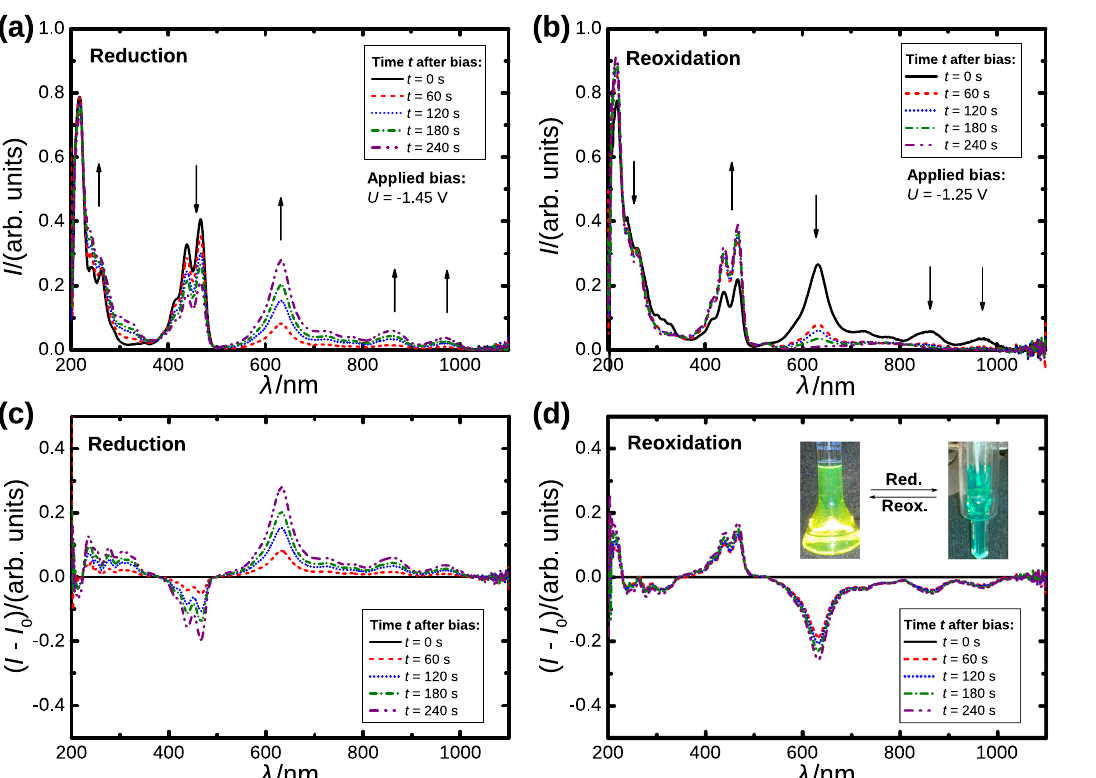
Figure 2. ( a ) Time dependent absorption spectra during reduction of PTTE under an applied bias of U = − 1.45 V. ( b ) Time dependent absorption spectra during reoxidation of the reduced PTTE under an applied bias of U = − 1.25 V. ( c , d ) Relative changes in the time dependent absorption spectra during reduction and reoxidation of PTTE. The spectra at the time of applying the bias U were selected as reference intensity I 0 . The inset in ( d ) exhibits the changes in color during reduction and reoxidation.